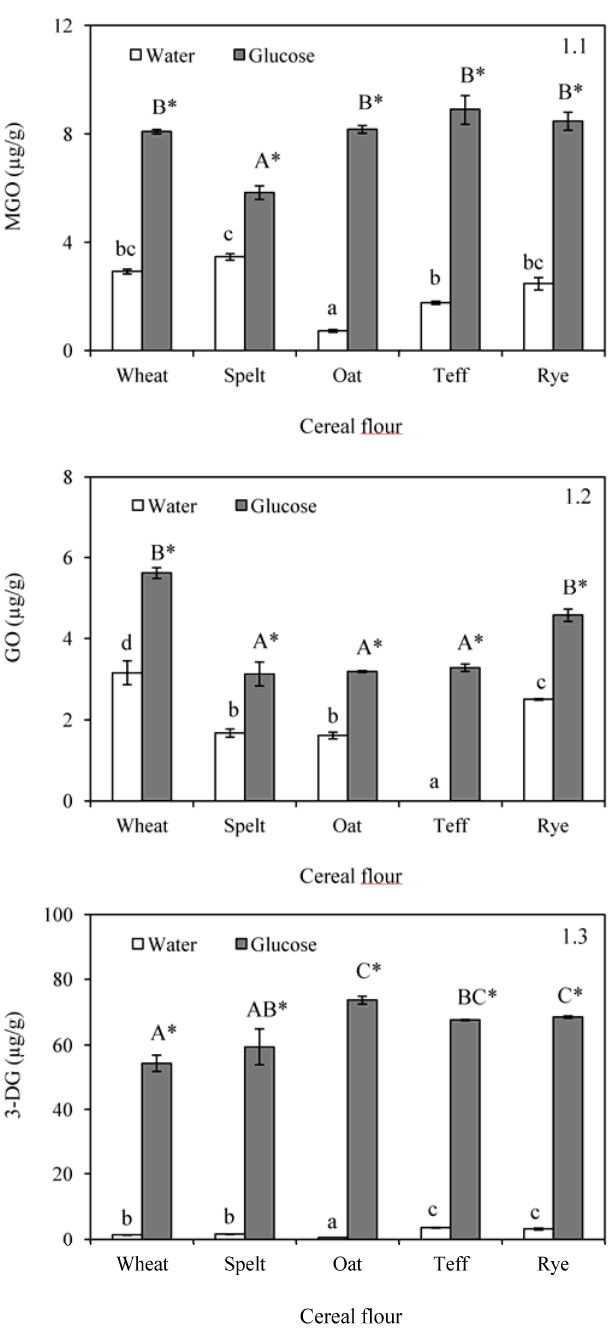
Figure 1. Formation of methylglyoxal (MGO) ( 1.1 ); glyoxal (GO) ( 1.2 ); and 3 ‐ deoxyglucosone (3 ‐ DG) ( 1.3 ) after baking in doughs formulated with water or glucose and wheat, spelt, oat, teff and rye flour. Results are mean ± standard deviation. a–d: Means with different small letters are significantly different ( p < 0.05) in baked doughs containing water. A–C: Means with different capital letters are significantly different ( p < 0.05) in baked doughs with added glucose. *: Asterisk means significant differences ( p < 0.05) between the same flour when compared glucose and water addition.